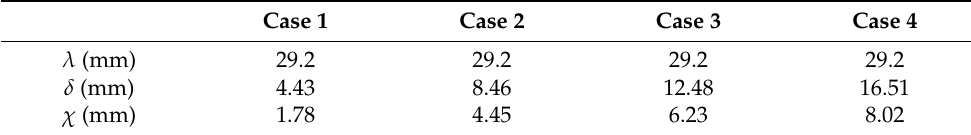
Figure 14. Cross-section morphology of the simulated cracks. Table 4. Crack location and morphology